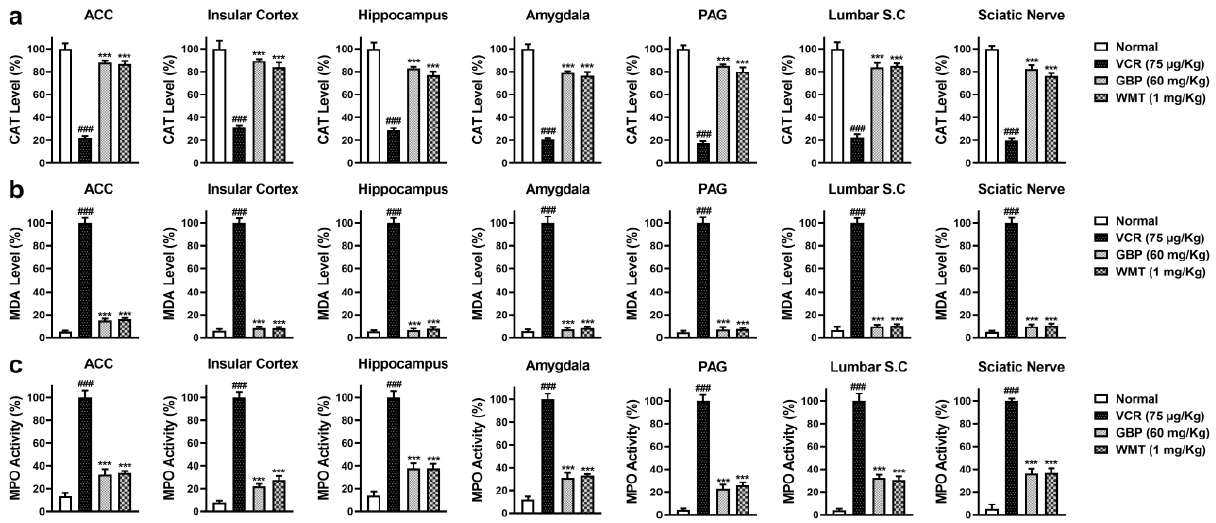
Figure 4. The effect of withametelin on the levels of the antioxidants and oxidative markers in the different regions of the brain, spinal cord, and sciatic nerve of the VCR model. Catalase ( a ), MDA ( b ), and MPO levels ( c ). The results were expressed in percentages. All results were expressed as the mean ( n = 5) ± SD. The experiment was performed in triplicate independently. ### p < 0.001 compared to the normal control group; *** p < 0.001 compared to the VCR group.